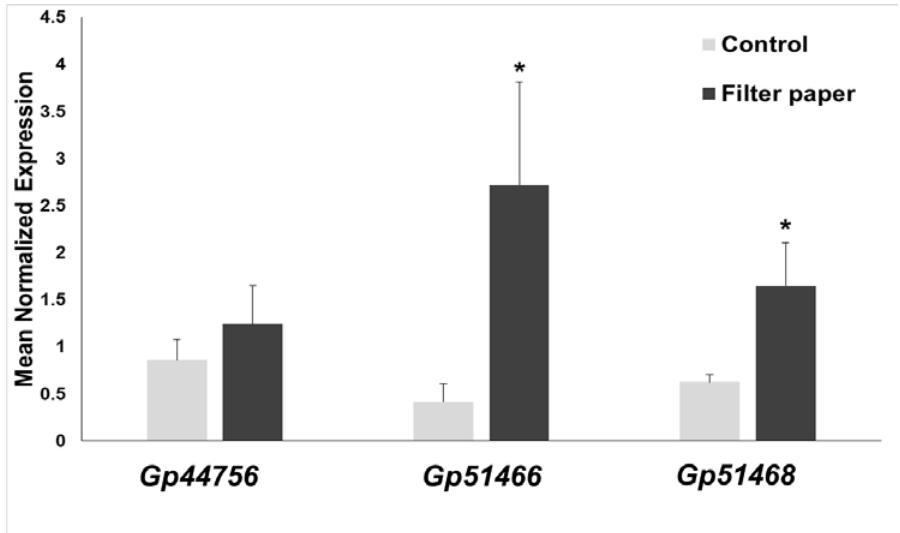
Figure 8. Gene expression analysis of the three G. pectorale cellulases after growth for 14 days under continuous light in the presence/absence of 0.1% ( w / v ) filter paper. Asterisks denote statistically-significant values after Student’s t -test (* p -value < 0.05).